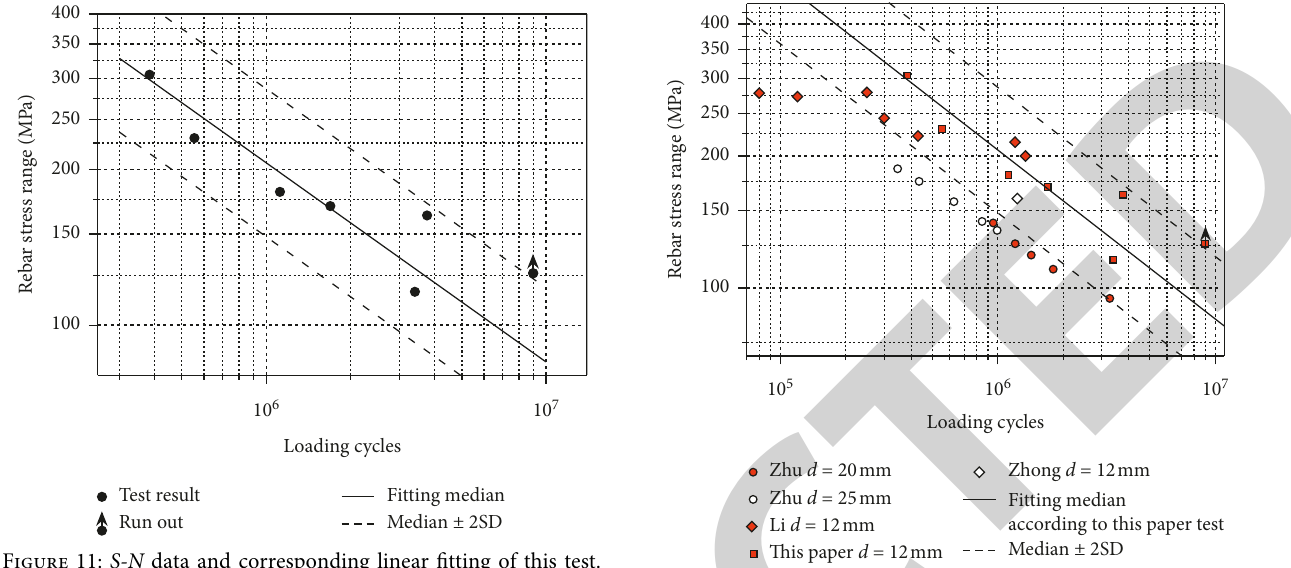
Figure 12: All test ( S-N) data collection and linear fitting of this test.